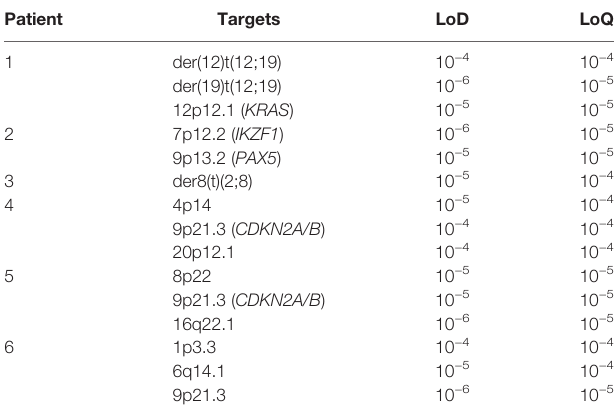
TABLE 2 | ddPCR assays limit of detection (LoD) and limit of quanti fi ability